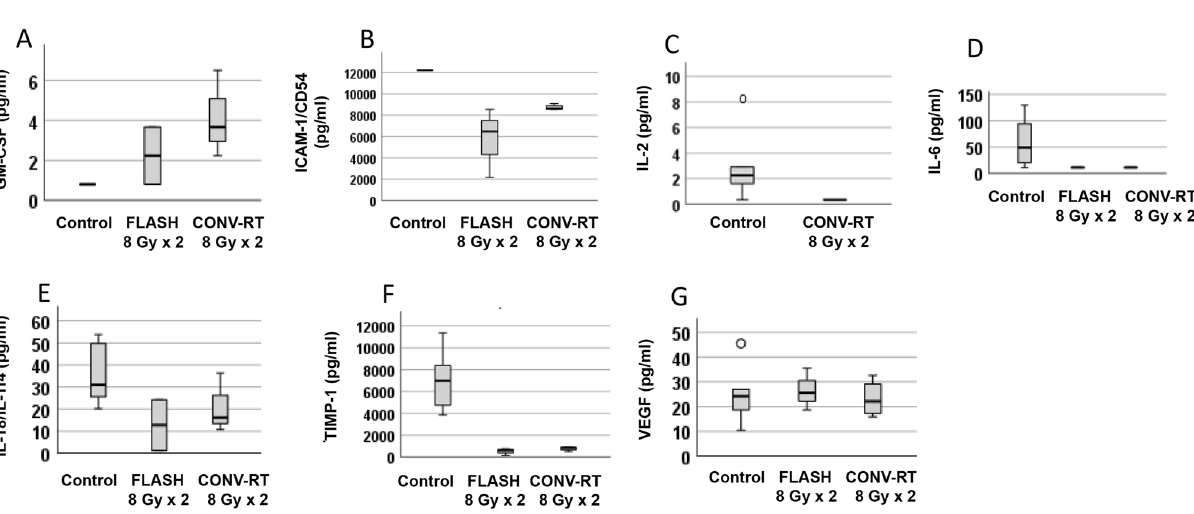
Figure 5. Serum levels in animals with subcutaneous tumors, comparing control animals to those irradiated with CONV-RT or FLASH. Serum was collected from the animals upon euthanasia, and those irradiated with FLASH 8 Gy × 2 and CONV-RT 8 Gy × 2 were compared to control animals. Missing data was due to values below the levels that could be technically detected, in all cases except ICAM-1/CD54 expression, where values were out of range above the levels that could be technically detected. TNF-alpha was below the reference interval in all animals, and could not be analyzed further. Non-parametric tests were used. * indicates significant differences compared to the control group. o indicates an outlier. ( A ) GM-CSF in n = 3 control animals, n = 2 FLASH 8 Gy × 2 and n = 3 CONV-RT 8 Gy × 2 treated animals. GM-CSF in a healthy animal was out of range below detectable levels. No significant difference was observed between different groups. ( B ) ICAM-1/CD54 in n = 1 control, n = 3 FLASH 8 Gy × 2 and n = 4 CONV-RT 8 Gy × 2 treated animals. ICAM-1/CD54 in healthy animal = out of range above the reference interval. N = 6 control animals exhibited values above the reference interval. No significant difference was observed amongst animals with detectable levels of ICAM-1/CD54. ( C ) IL-2 in n = 6 control versus n = 1 CONV-RT 8 Gy × 3 treated animals. IL-2 in healthy animal = 2.91 pg/ml. No significant difference was observed. ( D ) IL-6 in n = 7 control versus n = 1 FLASH 8 Gy × 2 and n = 2 RT 8 Gy × 2 treated animals. IL-6 in healthy animal = 29.77 pg/ml. No significant difference was observed. ( E ) IL-18 in n = 7 control versus n = 2 FLASH 8 Gy × 2 and n = 3 CONV-RT 8 Gy × 2 treated animals. IL-18 in healthy animal = 107.14 pg/ml. No significant difference was observed. ( F ) TIMP-1 in n = 7 control versus n = 3 FLASH 8 Gy × 2 and n = 4 CONV-RT 8 Gy × 2 treated animals. TIMP-1 in healthy animal = 1498.14 pg/ml. The levels differed significantly between controls and FLASH irradiated animals (Kruskal–Wallis p = 0.006, Mann–Whitney U-test with post-hoc Bonferroni correction p = 0.012 regarding FLASH 8 Gy × 2 versus control; p = 0.066 regarding CONV-RT 8 Gy × 2 versus control and p = 1.0 regarding FLASH 8 Gy × 2 versus CONV-RT 8 Gy × 2). ( G ) VEGF in n = 7 control versus n = 3 FLASH 8 Gy × 2 and n = 4